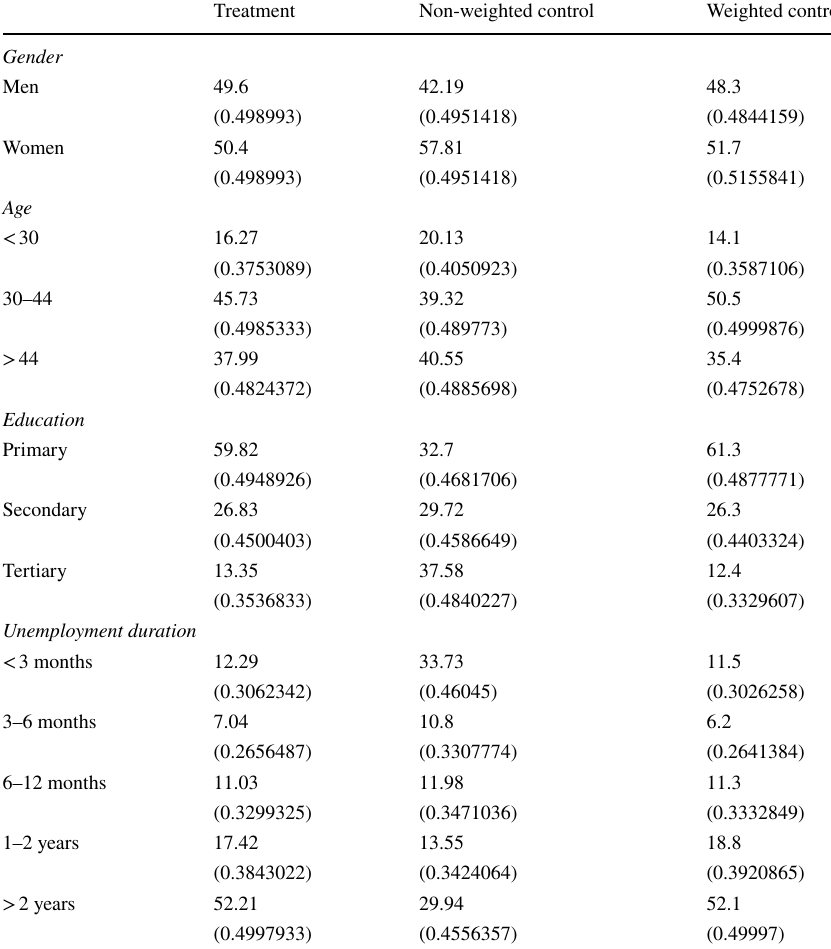
Table 2 Composition of the treated, non-weighted and weighted control groups in the analysis of the impact of MIS on the probability of finding a job